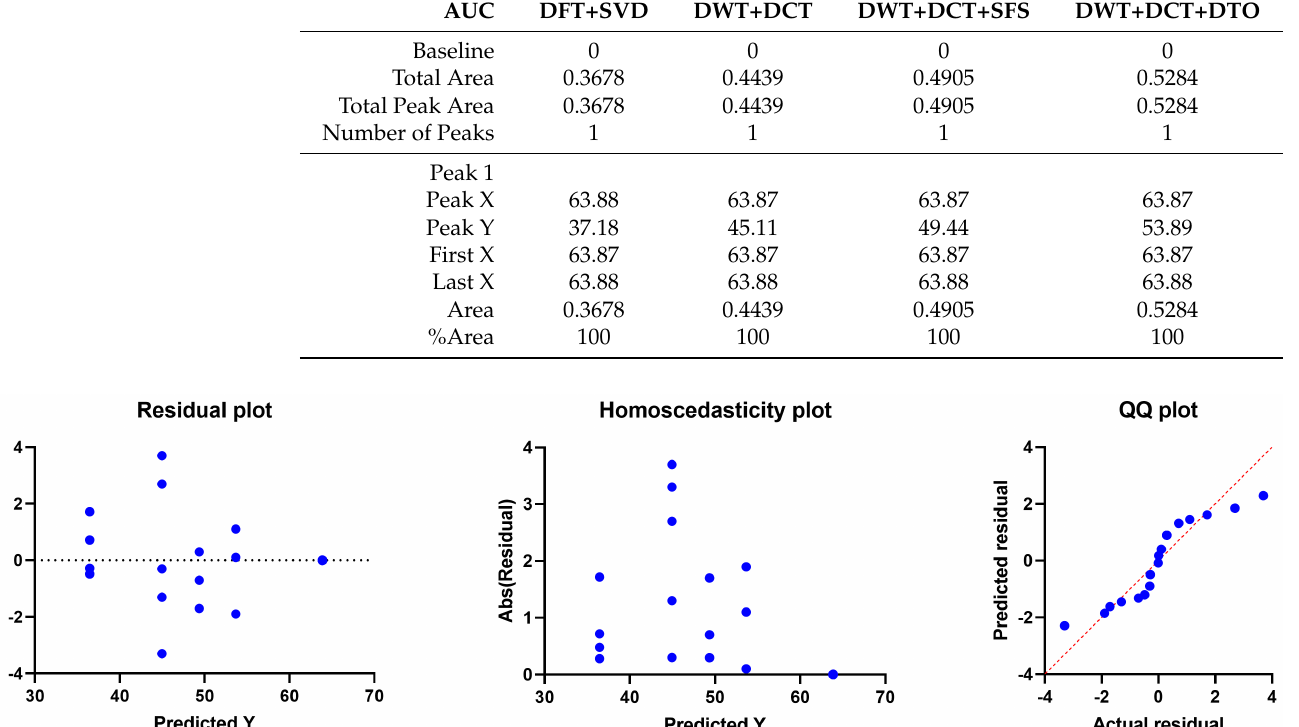
Table 6. Analysis of the area under the curve (AUC) of the results achieved with the proposed approach in comparison with the other approaches.